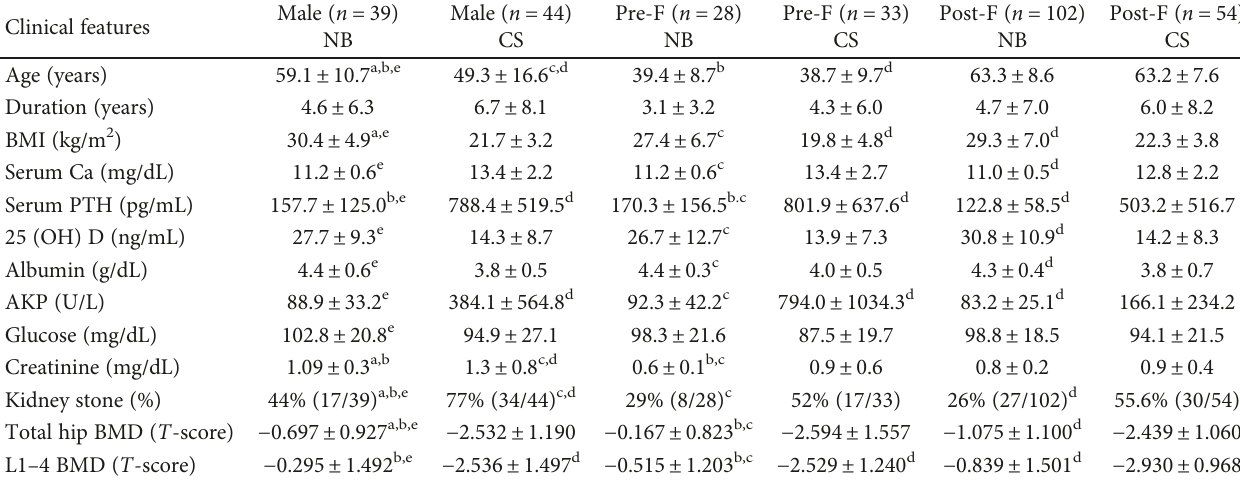
Table 2: Comparison between male and pre- and postmenopausal female PHPT patients from New Brunswick and Changsha. Clinical